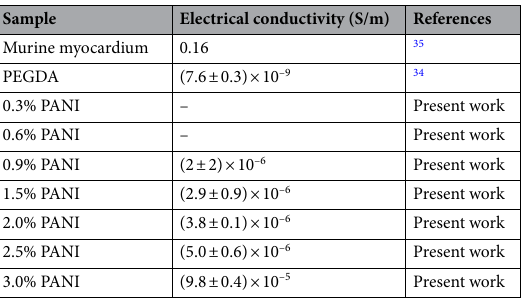
Table 2. Electrical conductivity of 3D printed scaffolds measured using the two-probe technique.